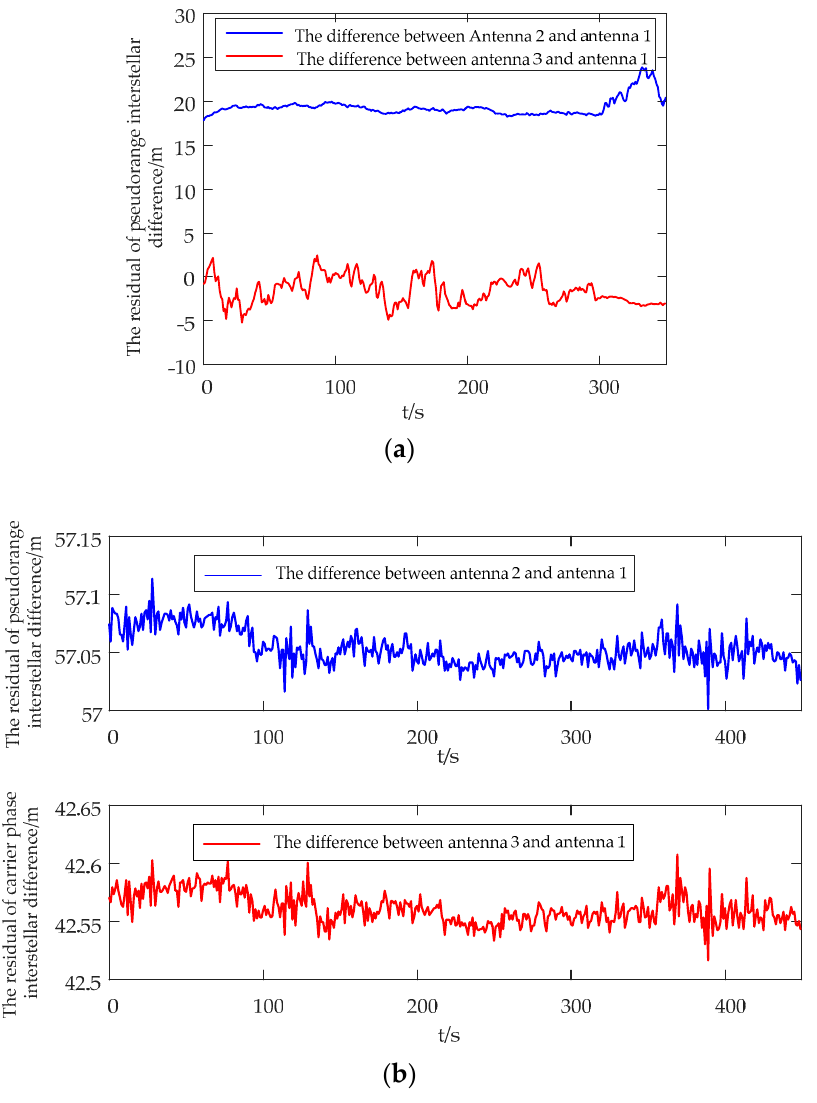
Figure 17. The residual of interstellar difference. ( a ) The residual of pseudorange interstellar difference. ( b ) The residual of carrier phase interstellar difference.